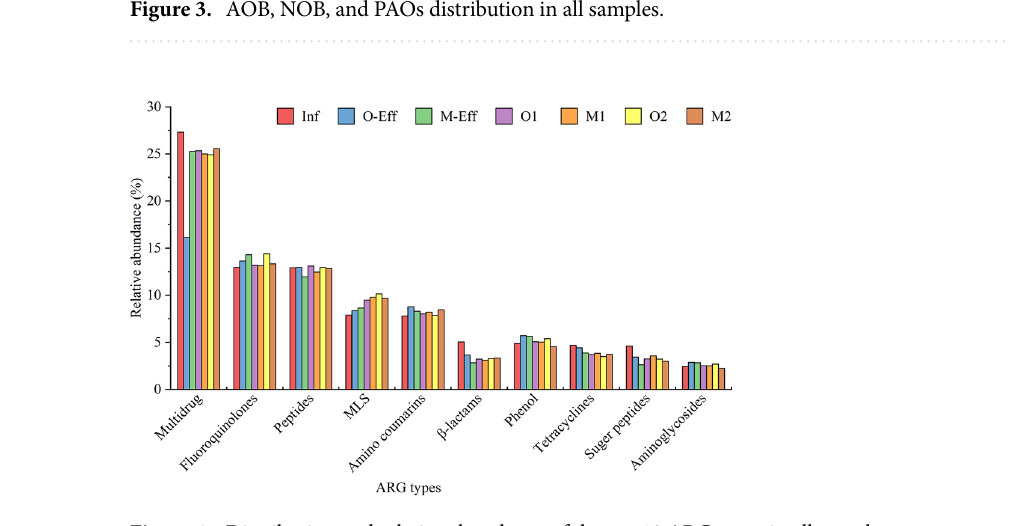
Figure 4. Distribution and relative abundance of the top 10 ARG types in all